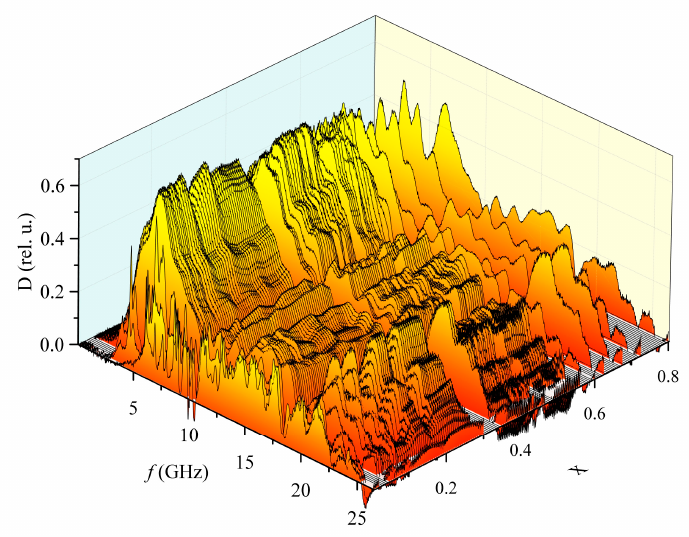
Figure 8. Dependence of the absorption coefficient on the frequency and composition of PZT system SS samples. The color is chosen for contrast, and to make this 3D pattern easier to associate with 2D heat maps.